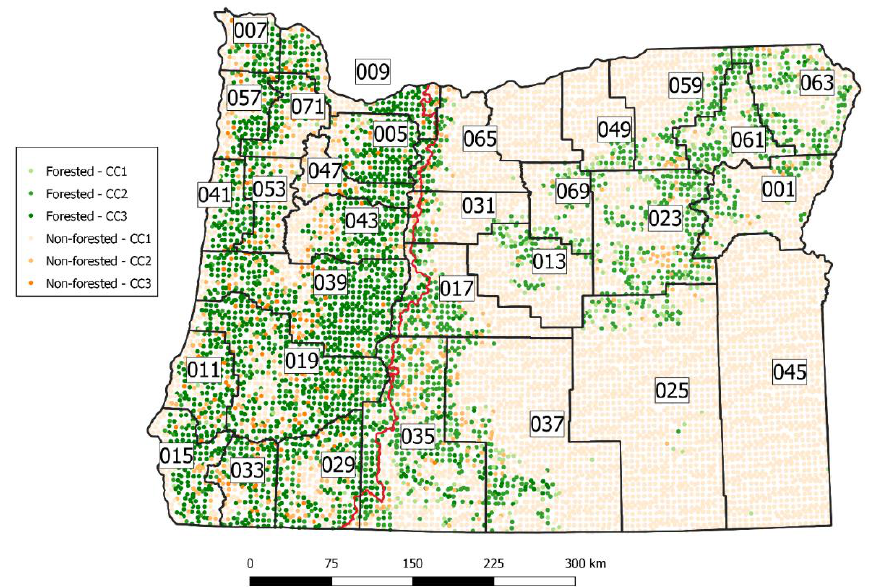
Figure 1. Map of the FIA field plots and subdomain boundaries for the state of Oregon, USA. Note that the publicly available FIA plot positions are used for display and to obtain the post-strata variables for this figure. Points are colored by their forested/non-forested status and canopy cover class. The east-west delineation used as an additional post-stratum is indicated by the red